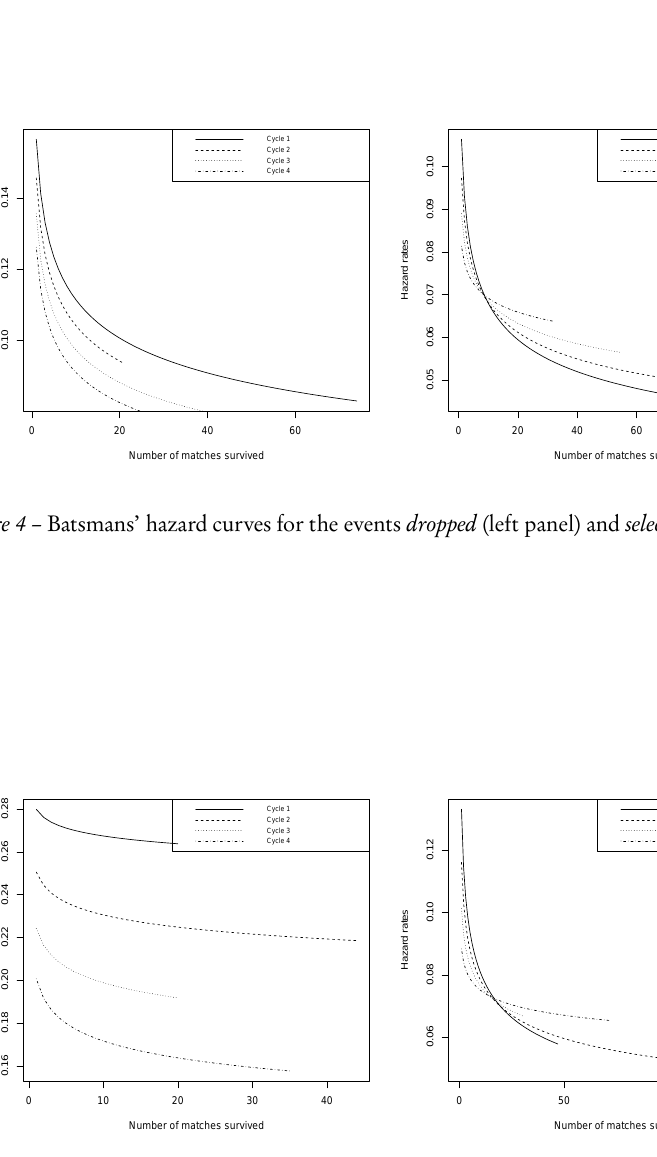
Figure 5 – Bowlers’ hazard curves for the events dropped (left panel) and selected (right